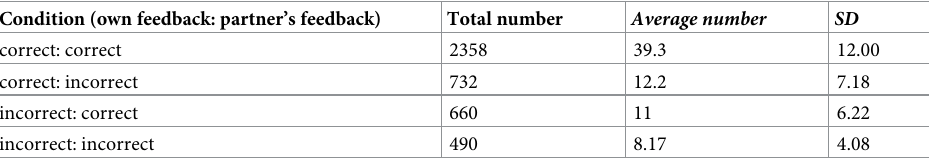
Table 1. Total number of trials and the average number of trials among participant for each condition. Condition (own feedback: partner’s feedback) Total